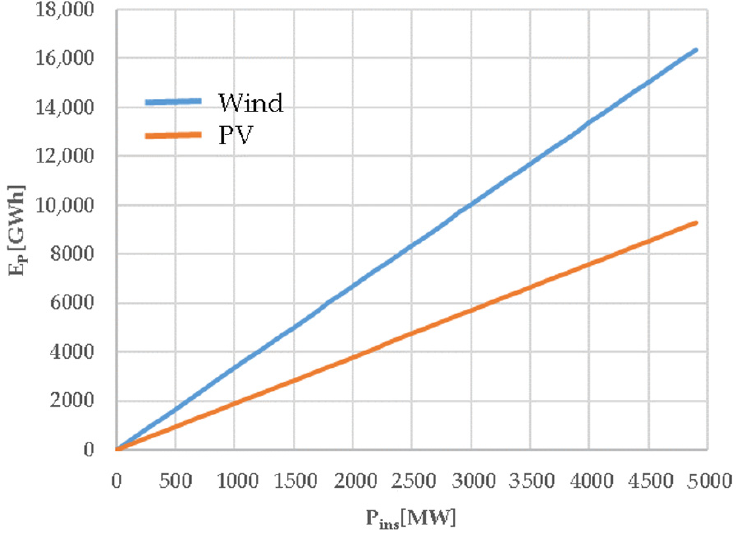
Figure 1. Annual energy output for the two base systems E P as a function of installed power P ins at Learmonth, Western Australia.